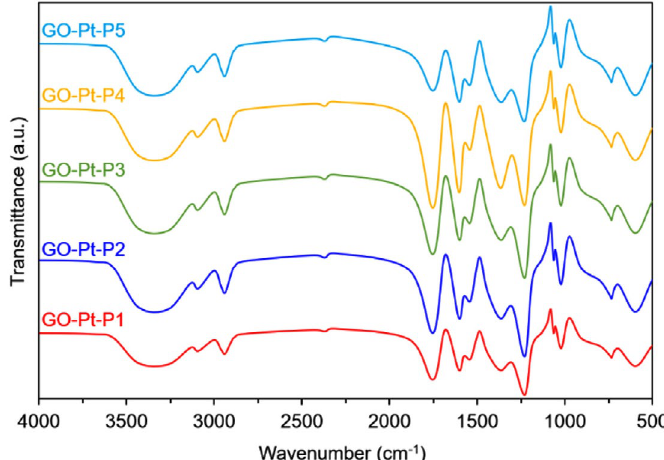
Fig. 7. Typical FTIR profiles of platinum nanoparticles loaded